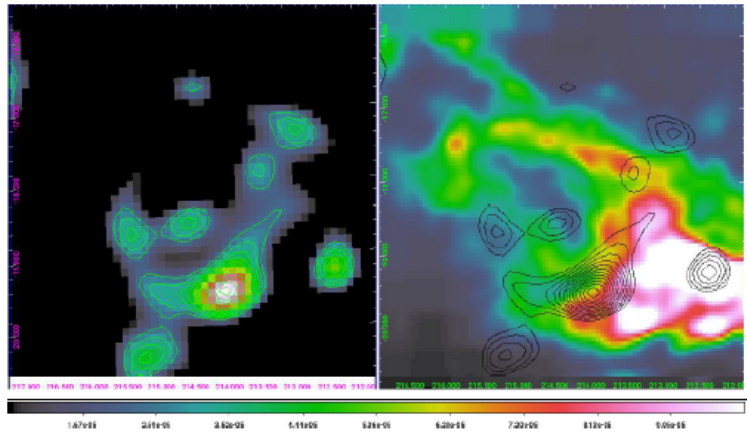
Figure 3. The Orion region around κ -Ori OB star. Left: γ -ray excess detected by AGILE. Right panel: CO map from [86] with contour levels from γ -ray data in black. The figure is from [64].